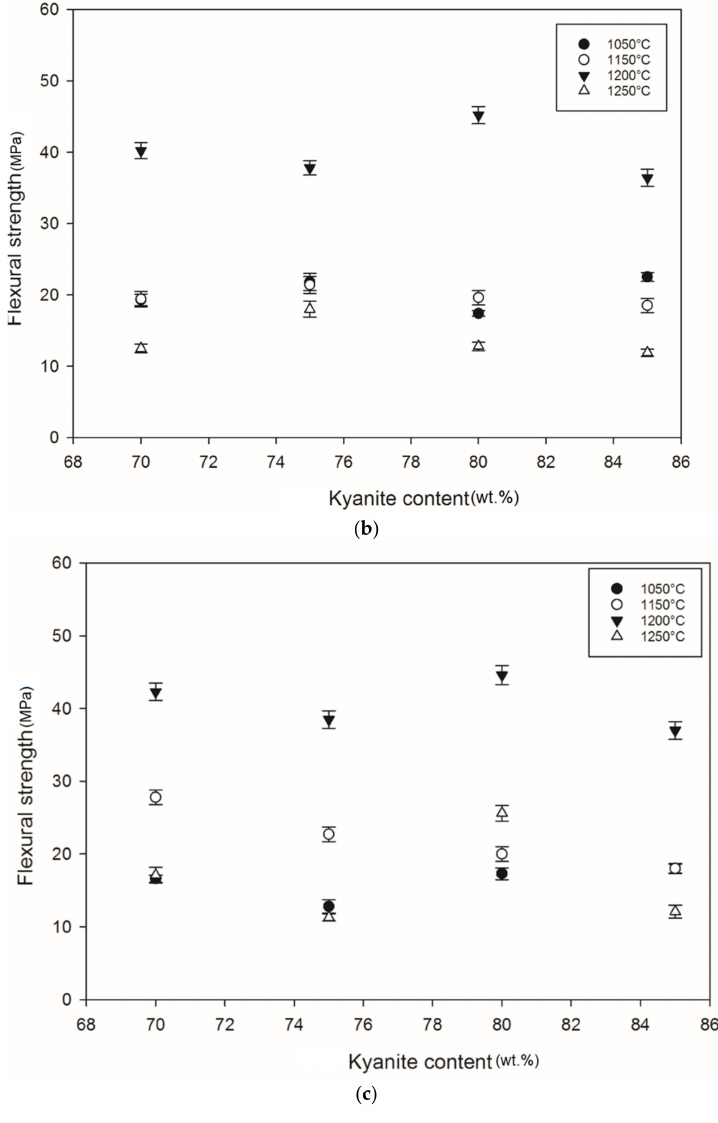
Figure 5. Flexural strength: ( a ) RB series, ( b ) RC series and ( c ) RD